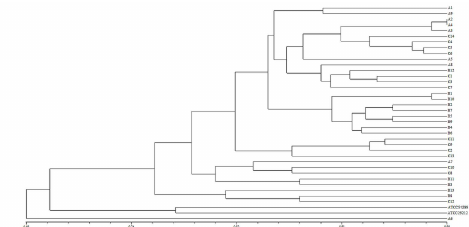
Fig 3. Dendrogram obtained after NTSYSpc analysis of MALDI-TOF MS